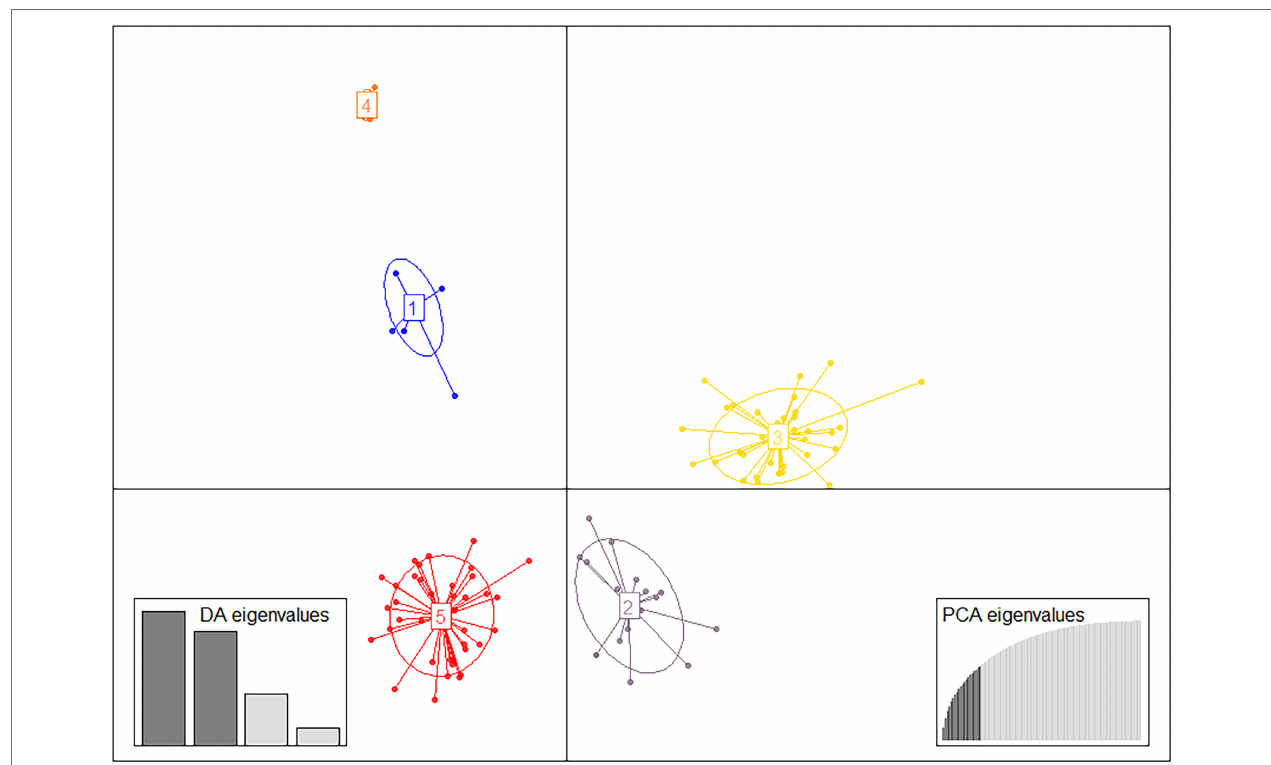
FIGURE 4 | Discriminant analysis of principal components (DAPC) for the 104 multilocus genotypes (MLGs) detected (clone corrected data). The axes represent the first two linear discriminants. Each ellipsis represents distinct genetic clusters, and dots represent individuals associated with unique MLGs. Eigenvalues indicate the amount of genetic information retained by the PCA (left inset) and the discriminant function (DA, right